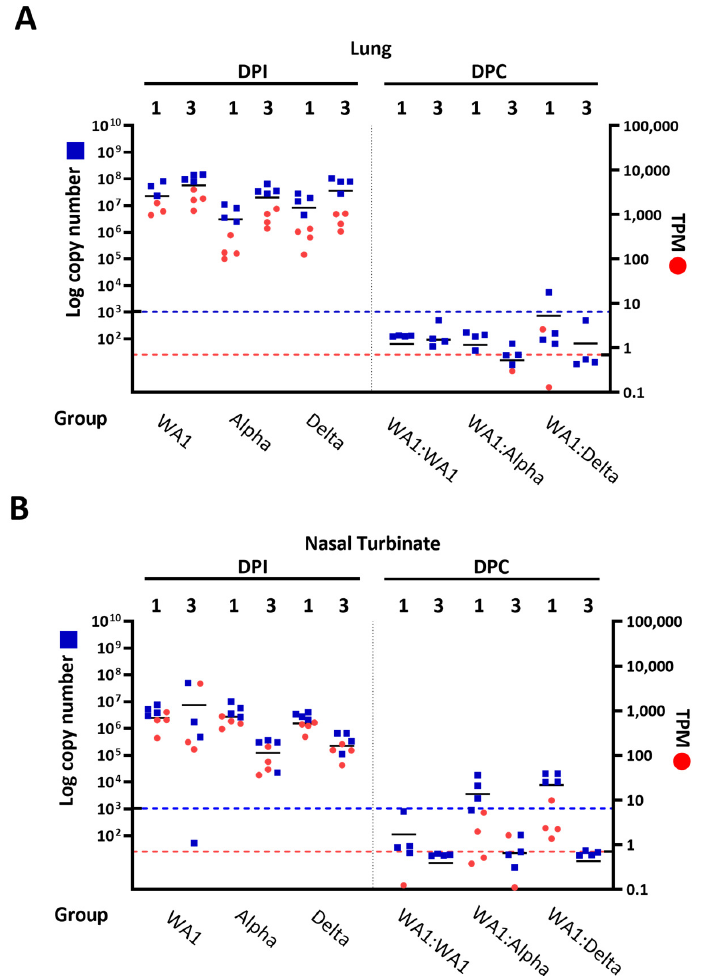
Figure 4. RT-qPCR data corroborate results from RNA-Seq to quantify virus recovered from lungs ( A ) and nasal turbinates ( B ) of mice. Log copy number of SARS-CoV-2 (left Y-axis) is overlayed with the transcripts per million (TPM) (right Y-axis). Groups are listed along the bottom X-axis based on their treatment and the day of organ collection is listed horizontally across the top of the graph. The blue horizontal dotted line serves as the lower threshold and marks the highest log copy number recorded in a sham-inoculated mouse. The red horizontal dotted line serves as the lower threshold of TPM and marks the highest TPM count in a sham-infected mouse. The vertical black dotted line in the middle of the graph separates the mouse groups with the infected on the left and the infected:challenged on the right. Abbreviations: dpi—days post-infection; dpc—days postchallenge.